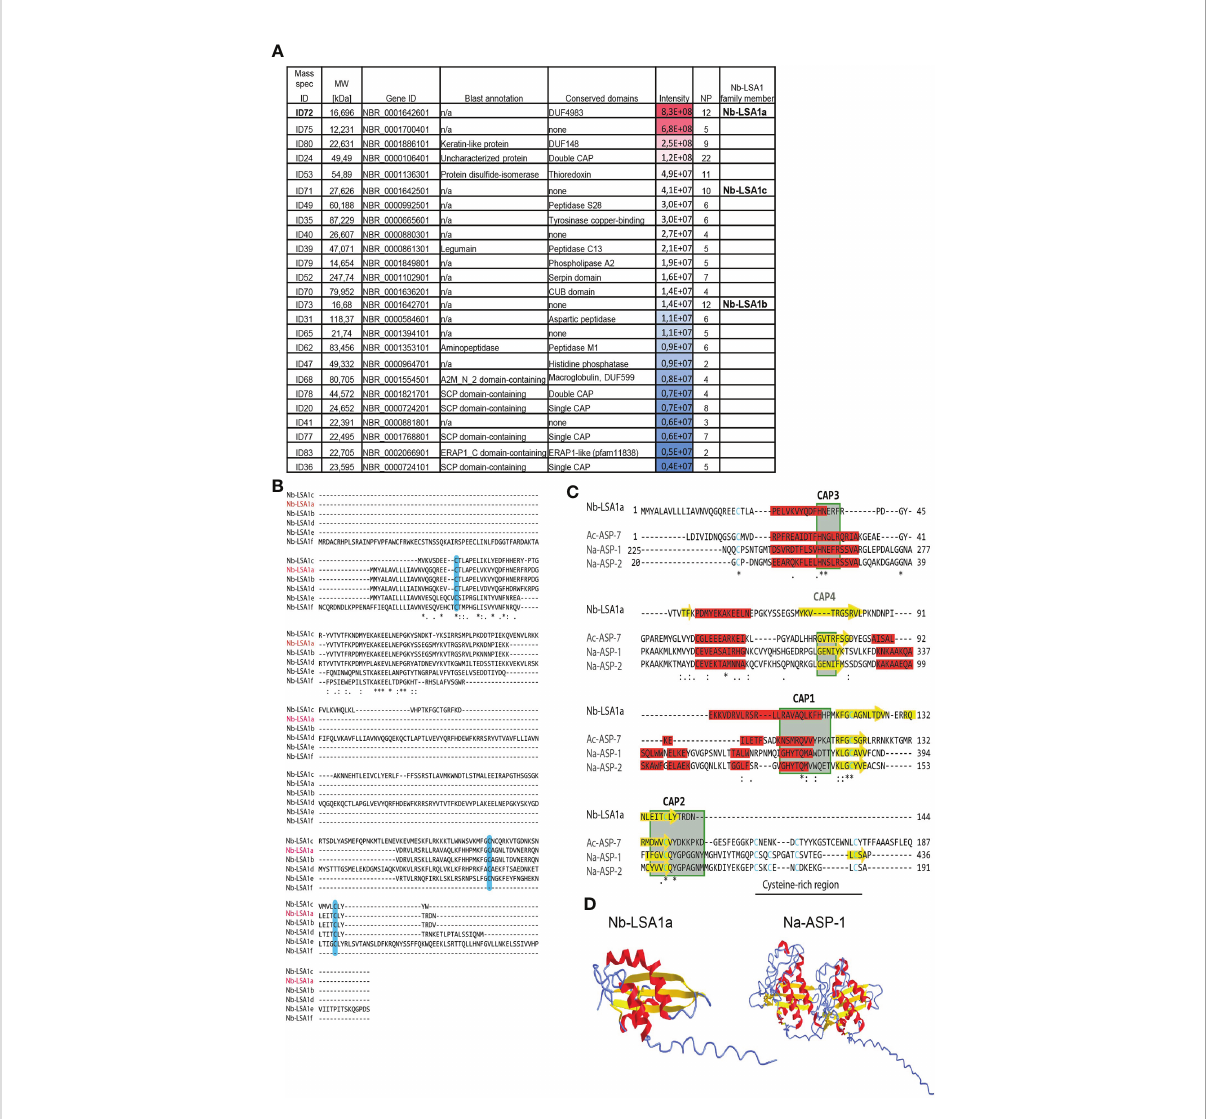
FIGURE 2 Top 25 most abundant proteins in the secretory proteins of Nb L3 stage larvae (NES). (A) Table summarizes the top 25 most abundant proteins in NES, representative for 2 separate LC-MS/MS runs. Mass spec identi fi cation numbers (ID) were assigned to distinguish between different proteins. Gene ID is taken from WormBase ParaSite database after Blast search for Nb genome annotations (Taxonomy ID 27835). Conserved domains were identi fi ed using PfamScan (EMBL-EBI) and CD-Search (from NCBI). Peptide intensity score is visualized by color code. MW, Molecular Weight; NP, Number of unique peptides; n/a, not available. (B) Multiple sequence alignment of fi ve Nb-LSA1a paralogues. The deduced amino acid sequence of the NBR_0001642601 gene, assigned Nb-LSA1a (red letters), was aligned to its fi ve paralogues, using Clustal Omega. The following consensus symbols are used for amino acid alignment: `*´ indicates identical alignment, `:´ indicates that substitutions are conserved, `.´ means weak similarity of substitutions; Cysteine residues are shaded in light blue. (C) Comparison of Nb-LSA1a sequence with selected CAP-domain proteins of known structure. Alignment of Nb-LSA1a with Ac-ASP-7 (PDB entry 3s6s), Na-ASP-1 (PDB entry 3nt8) and Na-ASP-2 (PDB entry 1u53). CAP domains 1-4 are shown in green boxes, Cysteine residues are shown in blue. The Cysteine-rich region, not present in Nb-LSA1a, is indicated by a black line. The same consensus symbols for amino acid alignment as in B were used. Sequence alignments were generated manually based on initial Clustal Omega prediction, secondary structures are shaded in red ( a -helix) and yellow ( b -strand) according to AlphaFold Protein Structure Prediction. (D) AlphaFold prediction and experimental structure for Nb-LSA1a and Na-ASP-1 with the same color-coding as in C. * indicates identitical alignment and ** or *** therefore simply means that two or three identical alignments are next to each